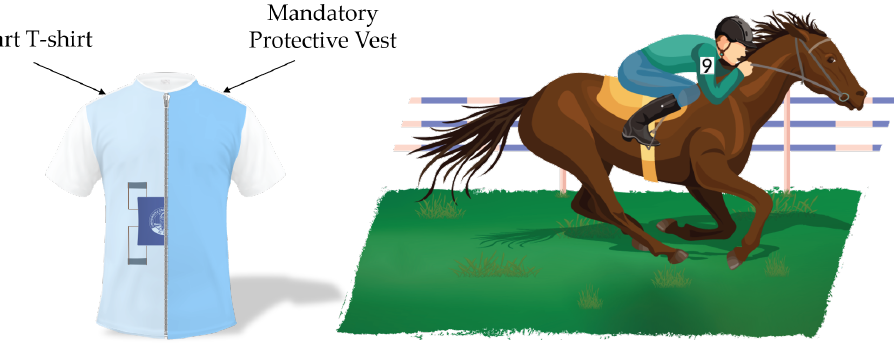
Figure 5. Schematic representation of how the wearable system is worn during the race (underneath the protective